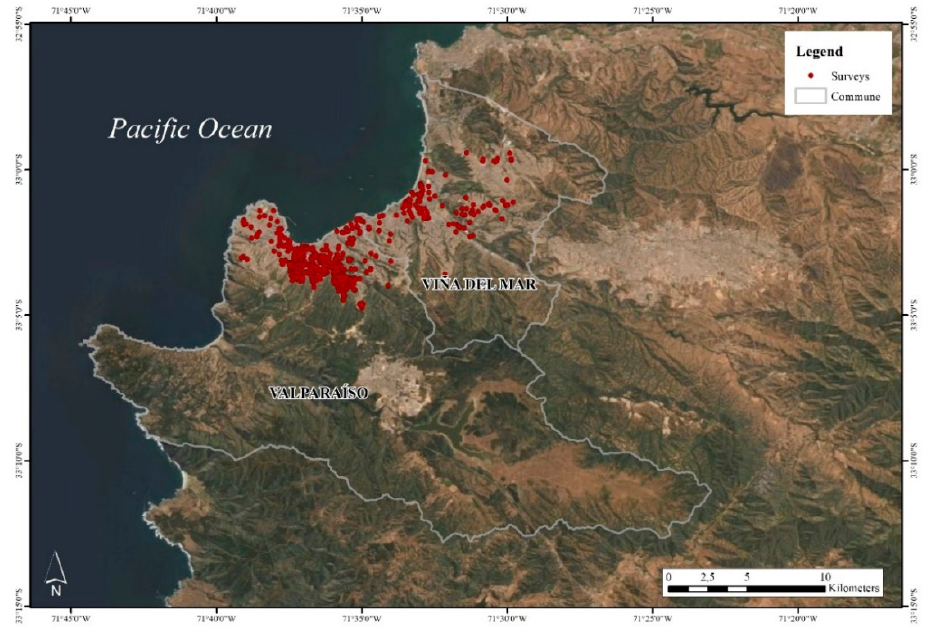
Figure A3. Location of the RRVS building survey in Valparaíso. Map data: figure modified from [59]. Map data © Google Earth 2020.